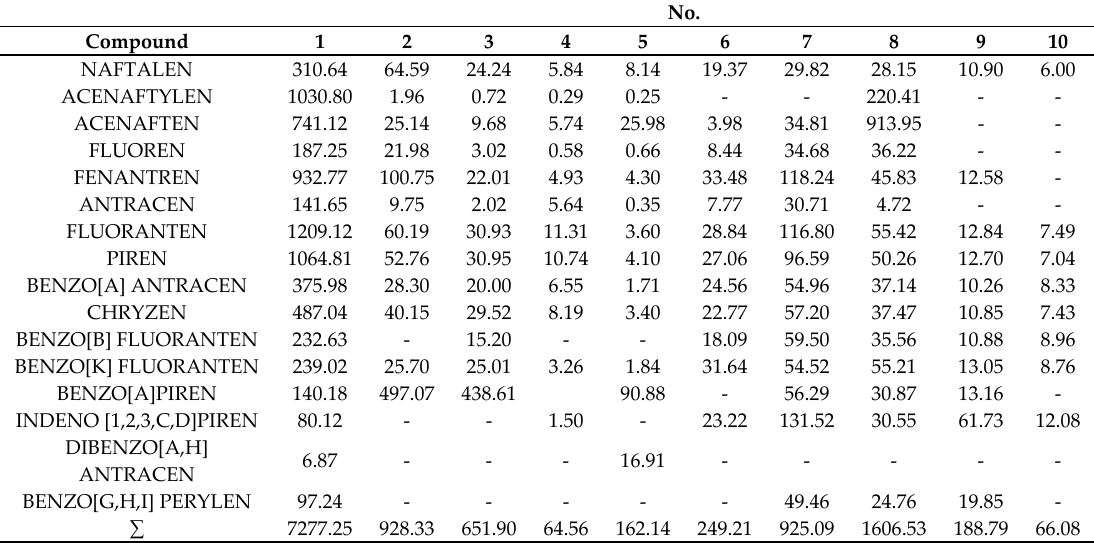
Table 2. Polycyclic aromatic hydrocarbon (PAH) content in the tested